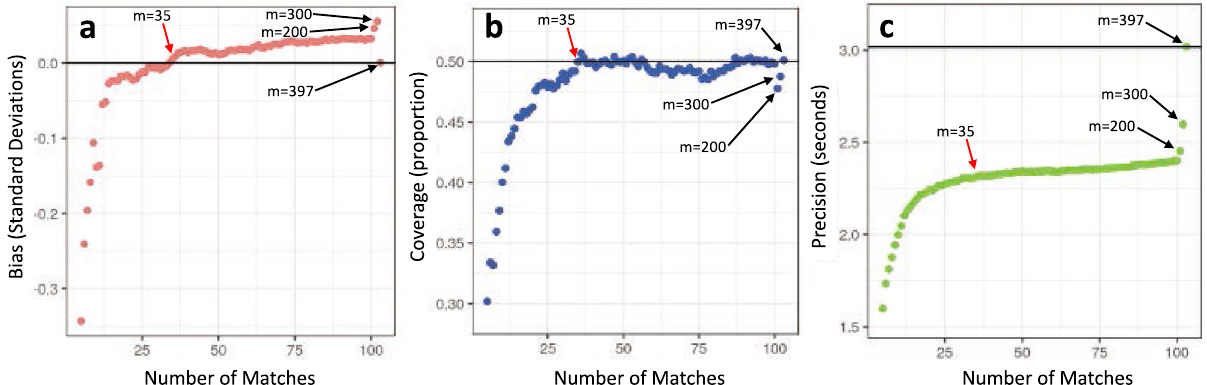
Figure 2. Performance metrics for neighbors-based predictions across increasing number of matches in the training dataset: ( a ) bias, ( b ) coverage, and ( c ) precision. The optimal number of matches (m = 35) is indicated with a red arrow.